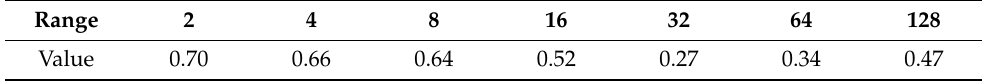
Table 5. H exponent values calculated using the RoverS method for a specific range.